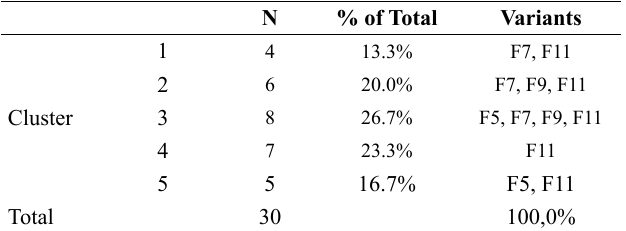
Table 2. Cluster Distribution.